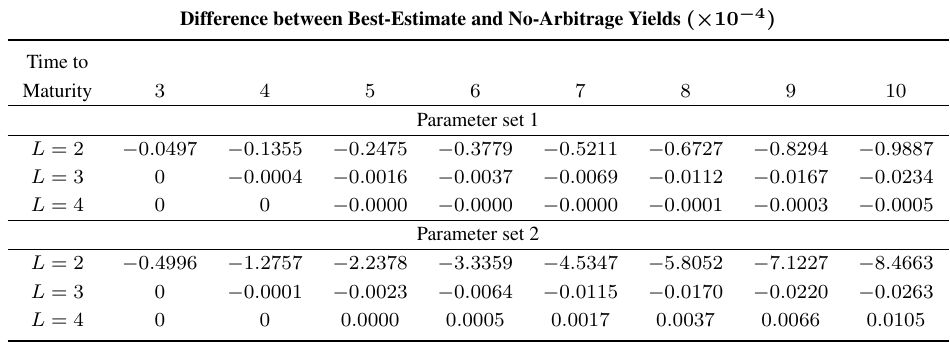
Table 2. Differences between the best-estimate and the no-arbitrage yields for different numbers L of traded bonds, for Parameter sets 1 and 2. Entries 0.0000 and -0.0000 indicate positive and negative numbers whose absolute value is less than 10 − 8